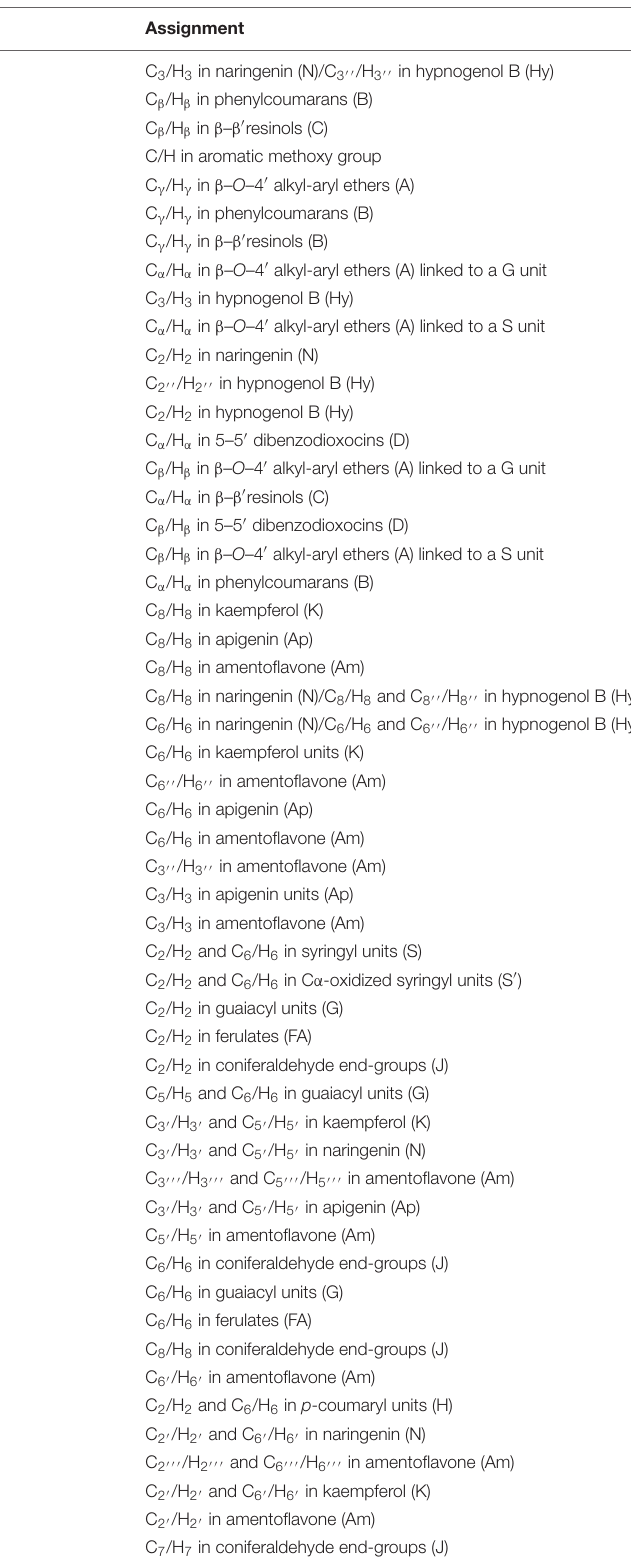
TABLE 2 | Assignments of the 1 H/ 13 C signals identified in the HSQC spectra ( Figures 3–6 ) of the lignin-like fractions isolated from the ancestral plants